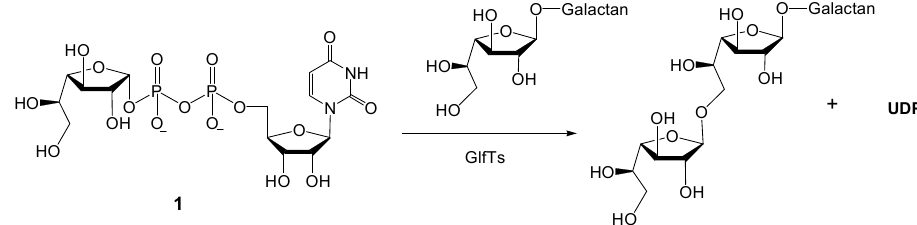
Scheme 1. The β -Gal f -(1 → 6)- β -Gal f transferase activity of mycobacterial galactofuranosyltransferase GlfT2. Gal f : galactofuranose.